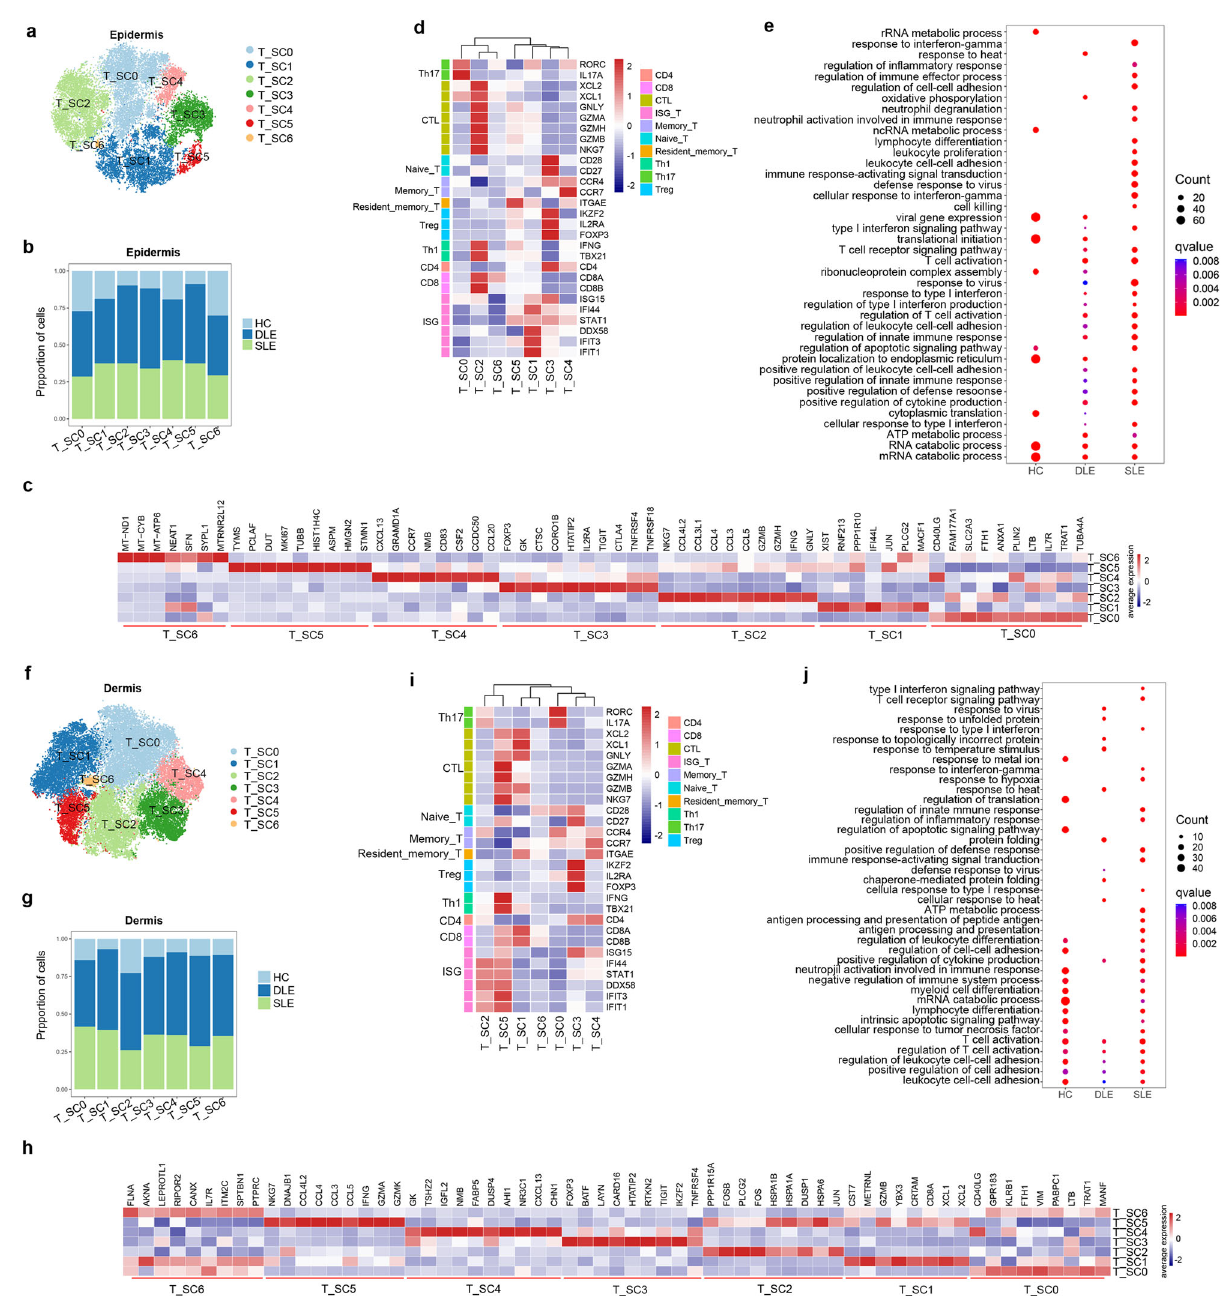
Fig. 5 | Sub-clustering analysis of T cells identi fi es major T cell subclusters in skintissues.a , f t-SNEplotsdistributionofTcellsubclusters(SCs)inepidermis( a ) andindermis( f ). b , g BarplotsshowtheproportionsofcellsfromHC,DLE,andSLE inTcellSCsofepidermis( b )anddermis( g ). d , i Heatmapsshowthespeci fi cclassic gene expression in SCs of epidermal ( d ) and dermal ( i ) T cells. The annotation of rows shows the classical subtypes of T cells with marker genes. CTL: Cytotoxic T